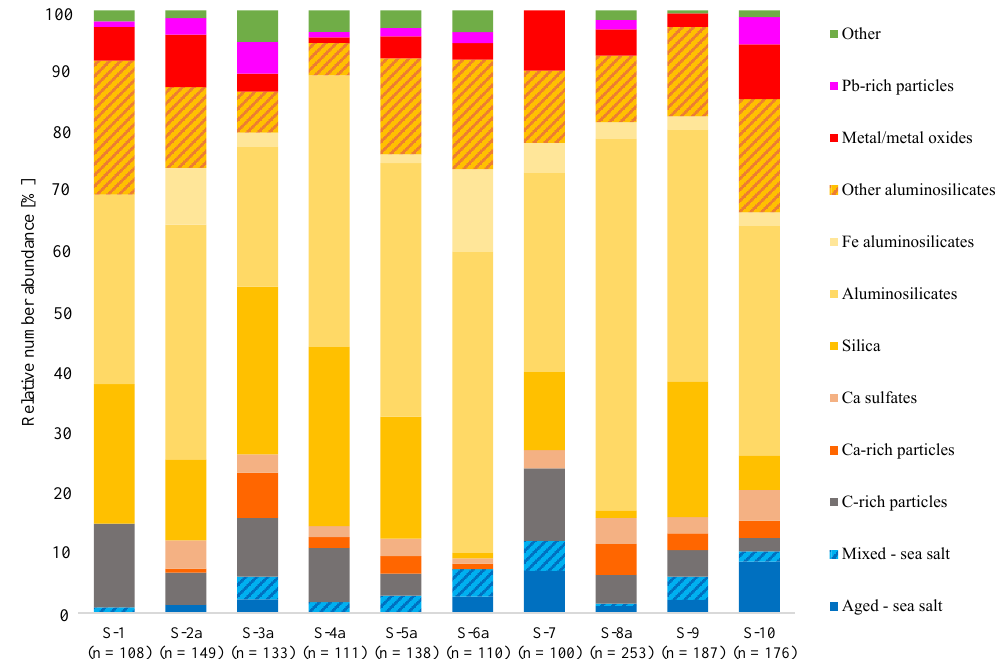
Figure 6. Relative number abundance of the different particle groups of IR sampled in mixed-phase clouds at site temperatures between − 10 and − 18 ◦ C. Sampling artefacts (pure salt, alumina, and Ni-rich and Cu-rich particles) are not shown.